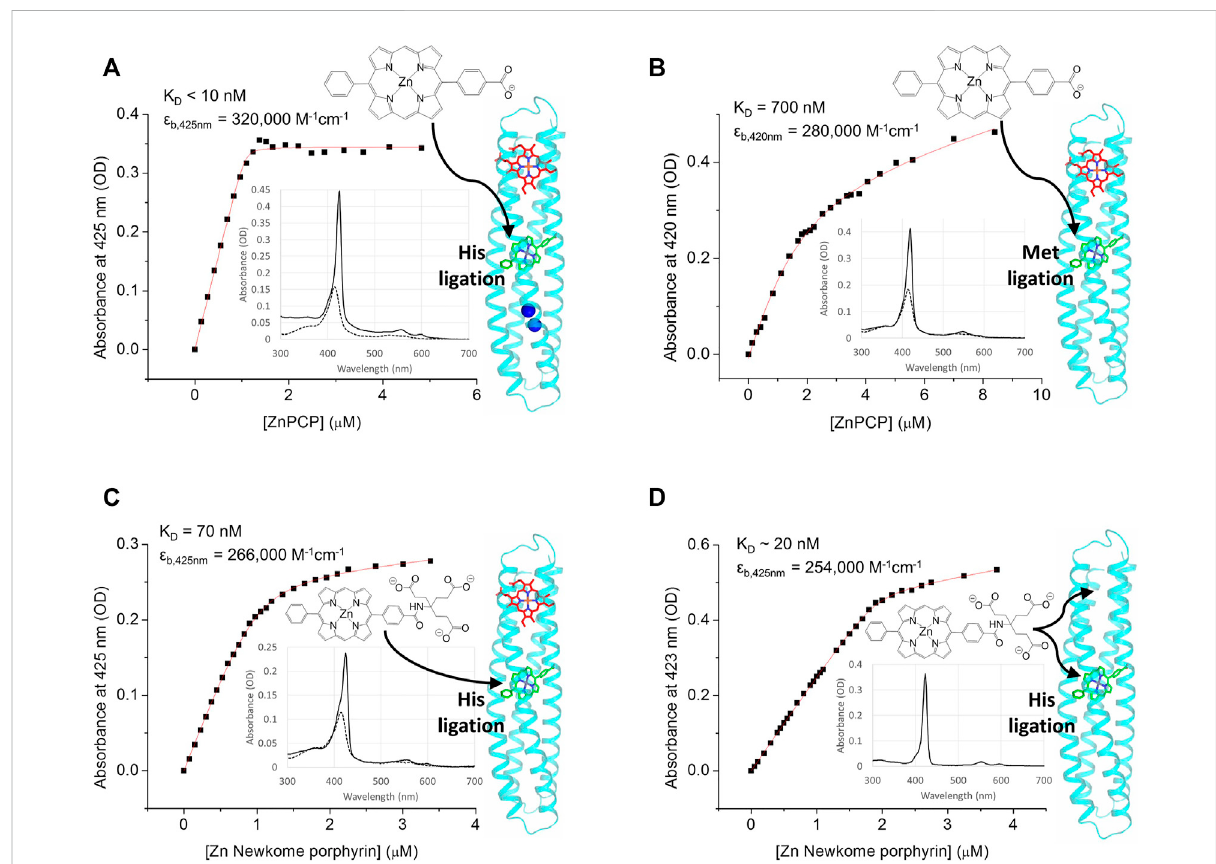
FIGURE 4 RC maquette pigment binding assayed by UV/vis absorbance titrations. For each plot, absorbance at the pigment Soret maximum (with heme absorbance subtracted out) is plotted against pigment concentration and fi t to a one-site binding equation (Eq. 2). The structure of the pigment is shown, and arrows indicate its likely binding location in the RC maquette on the right. Inset are spectra before pigment binding (dotted lines, with heme) and after the addition of 0.8 molar equivalents of pigment (solid lines). In panels (A – C) , a protein solution was prepared with 1.0 molar equivalent of heme B bound before titrating in the pigment; in each case 1.0 pigment molecule binds per protein-heme complex. (A) Binding of ZnPCPto 1.2 µMRCmaquette-hemewith 1.5 mMZnCl 2 .Conditions:15 mM NaCland10 mM PIPESbufferatpH6.5. (B) BindingofZnPCPto 1.4